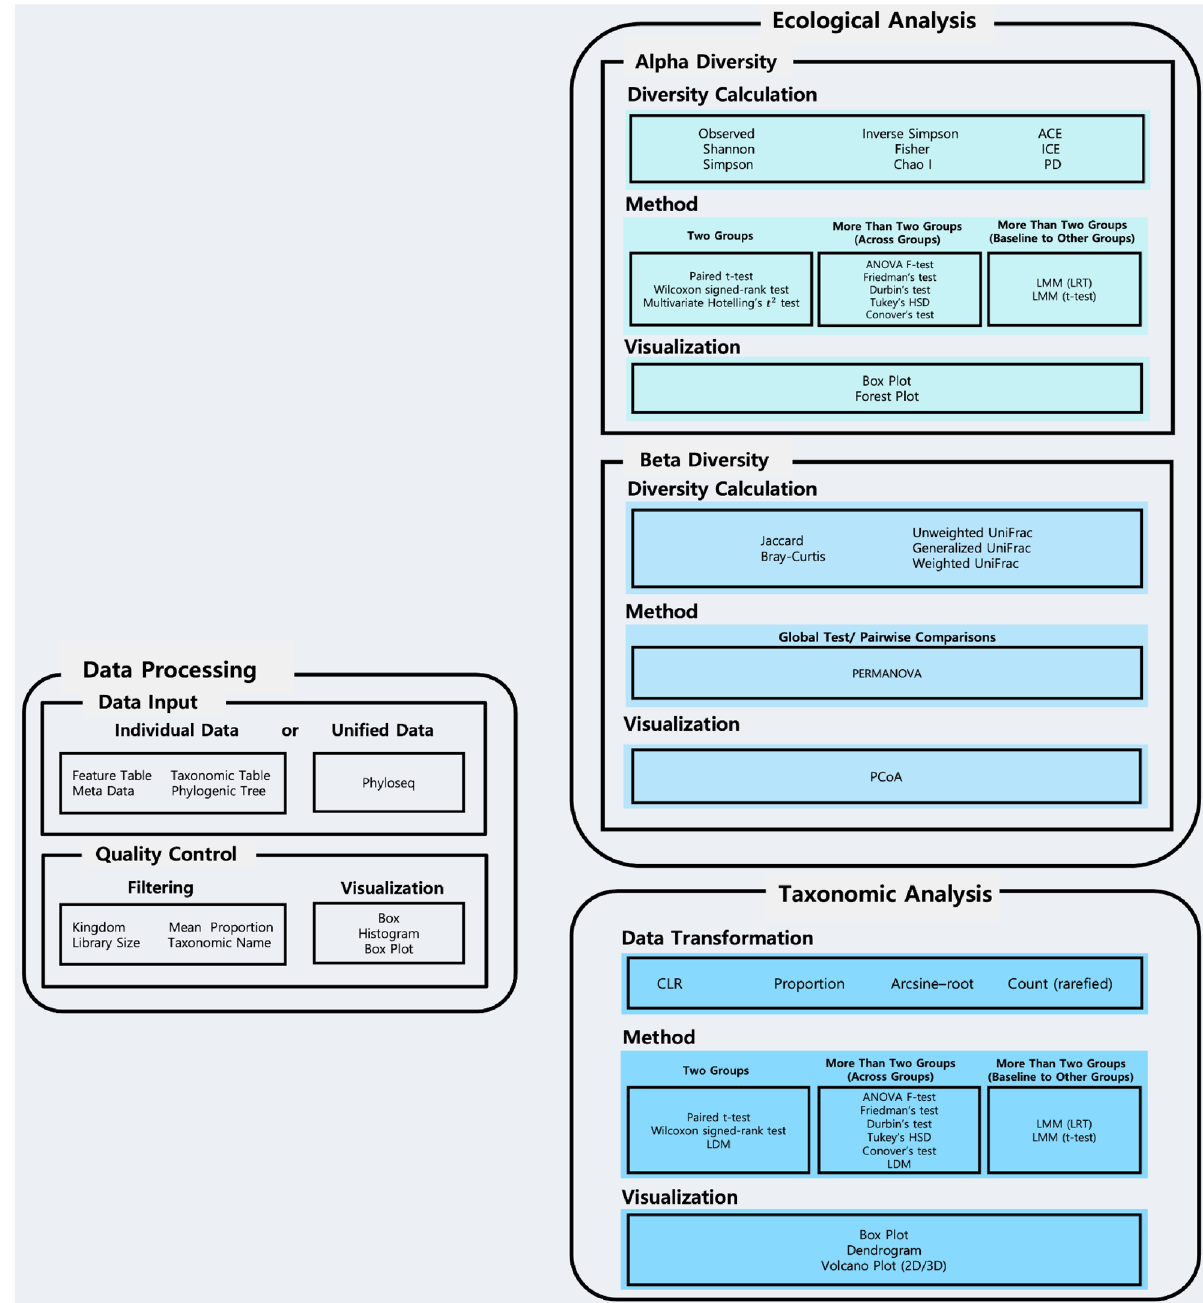
Figure 1. Overall workflow for MiPair. MiPair starts with a data processing component: data processing and then moves to two data analytic components: ecological analysis and taxonomic